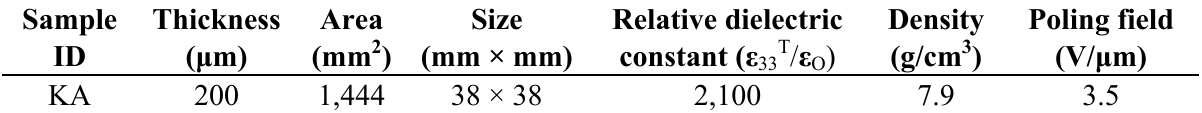
Table 2. Properties of the commercial PZT pyroelectric